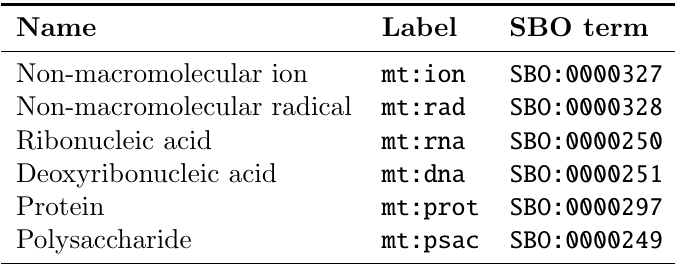
Table 2.2: A sample of values from the material types controlled vocabulary (Section 2.2.1).